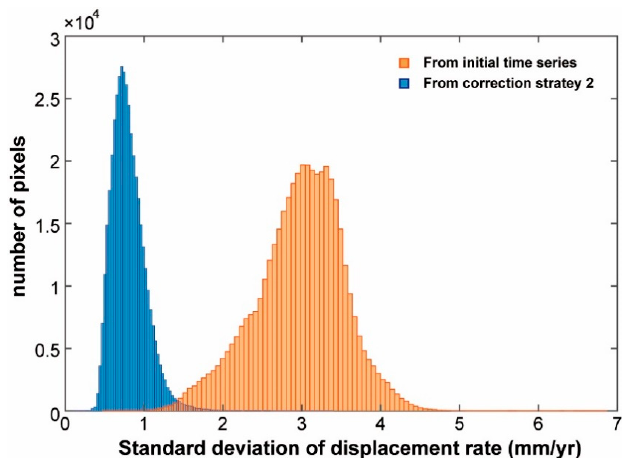
Figure 7. Histograms of standard deviations of displacement rates derived from the initial time series and corrected time series obtained from Strategy 2.